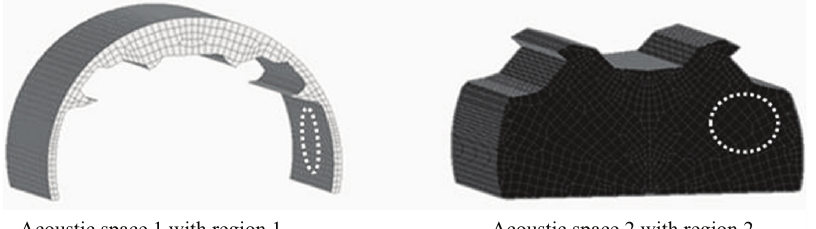
Fig. 2. Definitions of regions 1 and